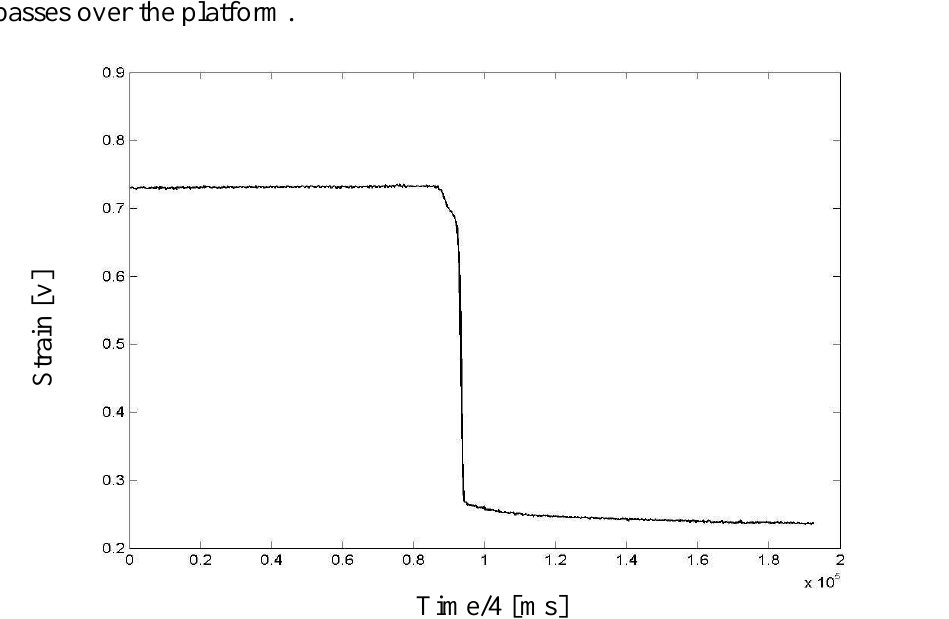
Figure 8. Response of the sensor after an applied force vanishes.